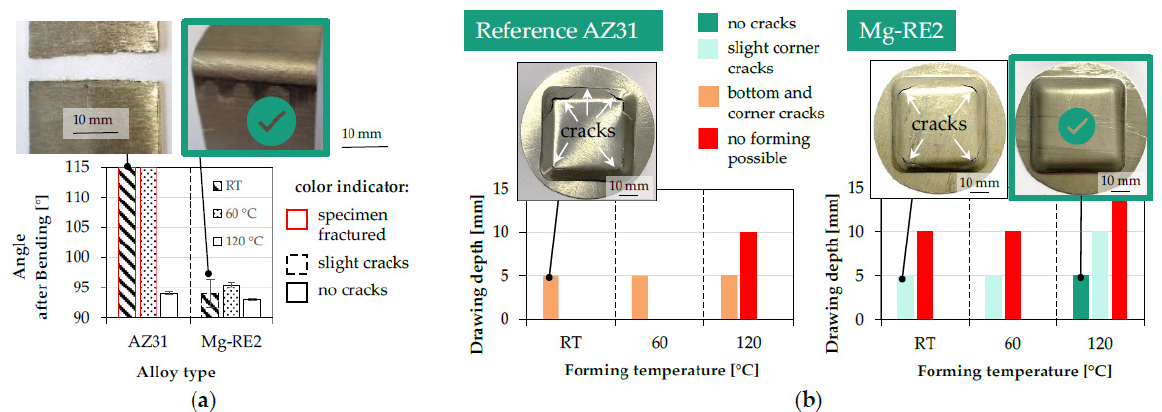
Figure 4. Forming tests in laboratory scale: ( a ) Results of bending tests for tool with bending radius of 2 mm, rolling direction parallel to bending line, three repetitions for each configuration; ( b ) Results of lubricated deep drawing tests at different temperatures; drawing gap: 2.0 mm, punch and die radii: 5 mm, lubrication: Zeller+Gmelin Multidraw KTL-N16, three repetitions for each configuration. 5 mm, lubrication: Zeller+Gmelin Multidraw KTL-N16, three repetitions for each